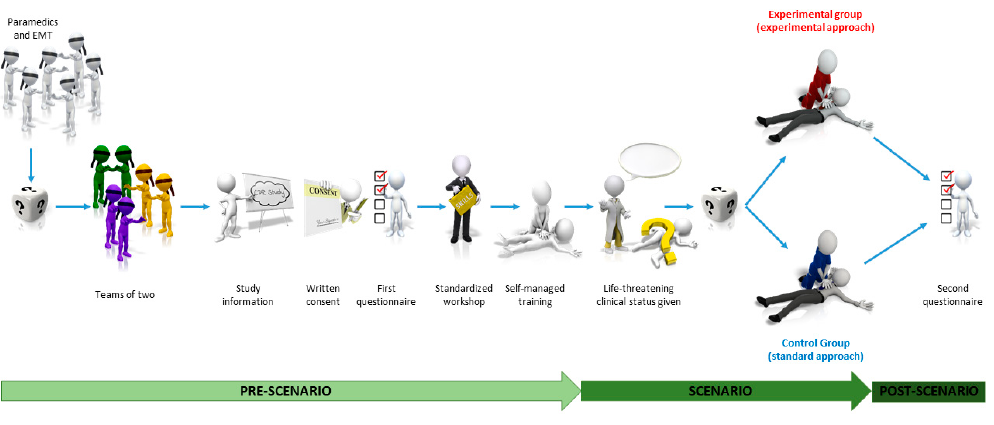
Figure 2. Study Figure 2. Study sequence.